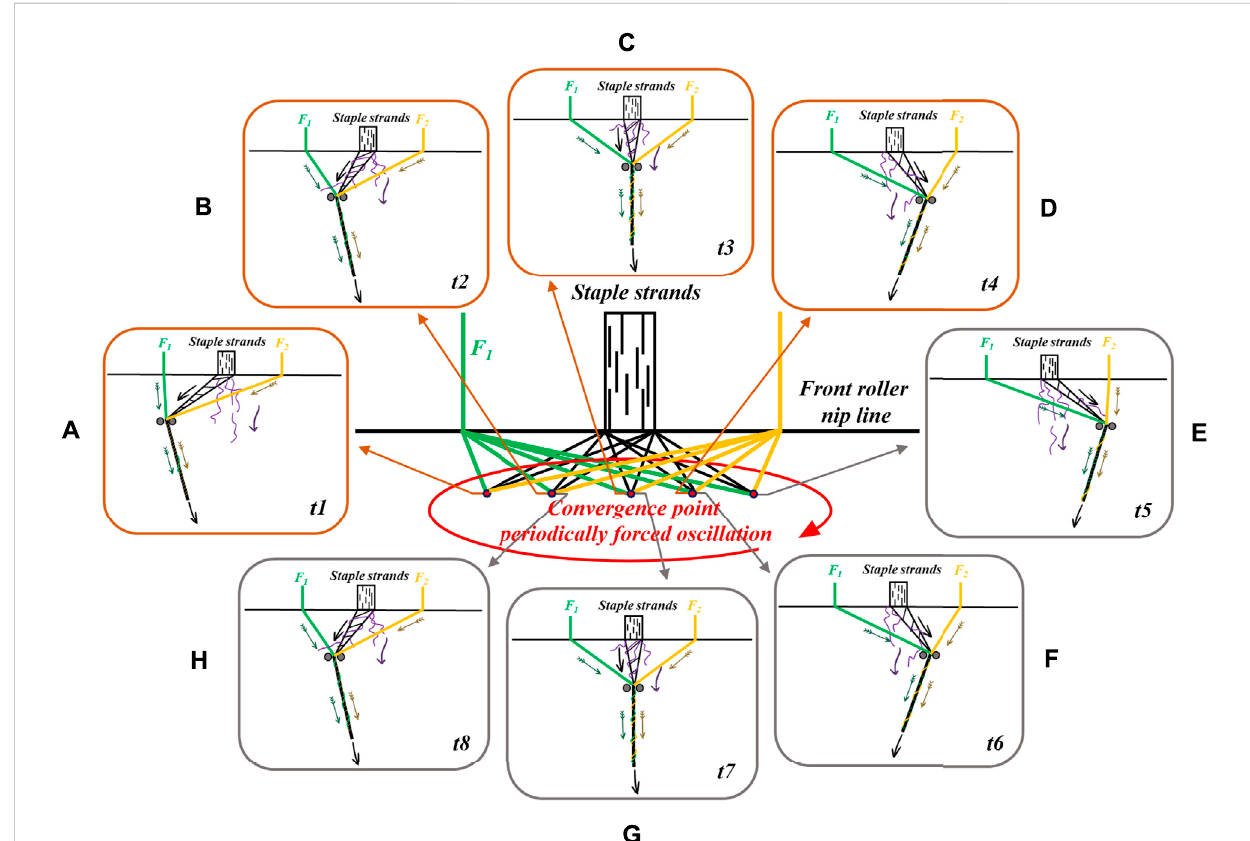
FIGURE 1 Geometric illustration of fi bers trajectory: (A-H) shows two fi laments wrapped around a short chain to form a spiral structure.